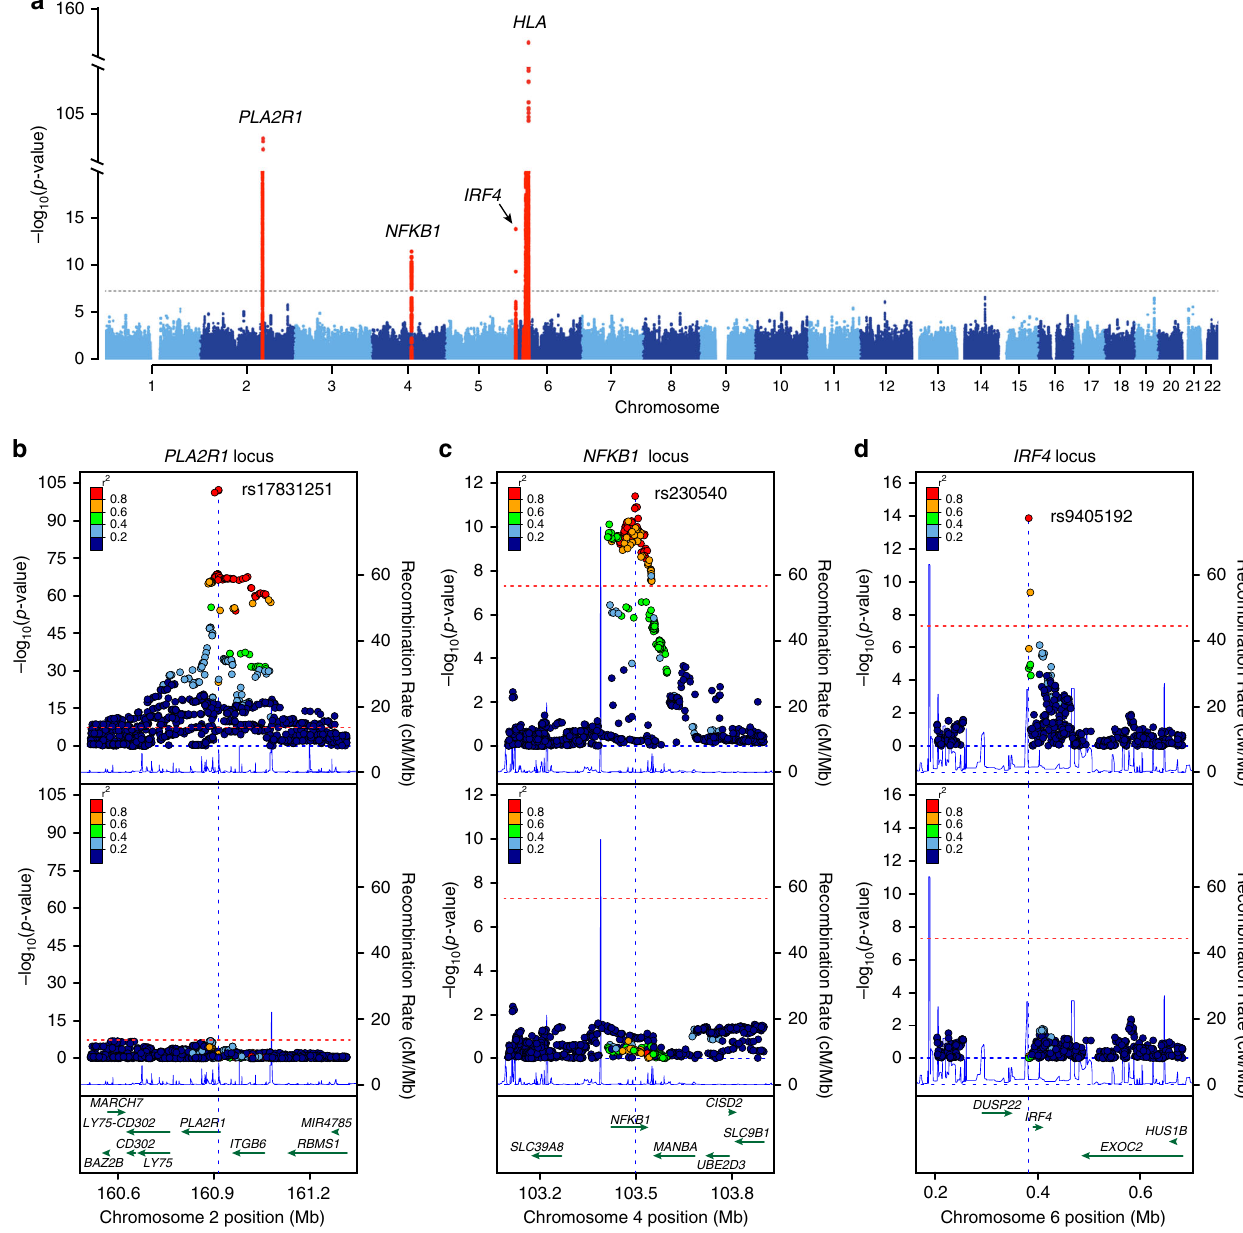
Fig. 1 Manhattan and regional plots for non-HLA loci for the combined meta-analysis of all MN cohorts. a The results of the combined meta-analysis across all cohorts; the dotted horizontal line indicates a genome-wide signi fi cance threshold ( α = 5 × 10 − 8 ); the y -axis is truncated twice to accommodate large peaks over PLA2R1 and HLA loci; genome-wide-signi fi cant loci highlighted in red; b Regional plot for the PLA2R1 locus; the upper panel shows unconditioned meta-results, the lower panel depicts meta-results after conditioning for the top SNP (rs17831251). c Regional plot for the NFKB1 locus; the upper panel corresponds to unconditioned results; the lower panel shows meta-results after controlling for rs230540. d Regional plot for the IRF4 locus; the upper panel corresponds to unconditioned results; the lower panel shows meta-results after controlling for rs9405192. The x -axis denotes genomic location (hg19 coordinates), left y -axis represents – log P values for association statistics, right y -axis represents average recombination rates based on HapMap-III reference populations combined (blue line). In the conditional analyses, we conditioned on the top SNP in each individual cohort, then meta- analyzed conditioned summary statistics as described in the